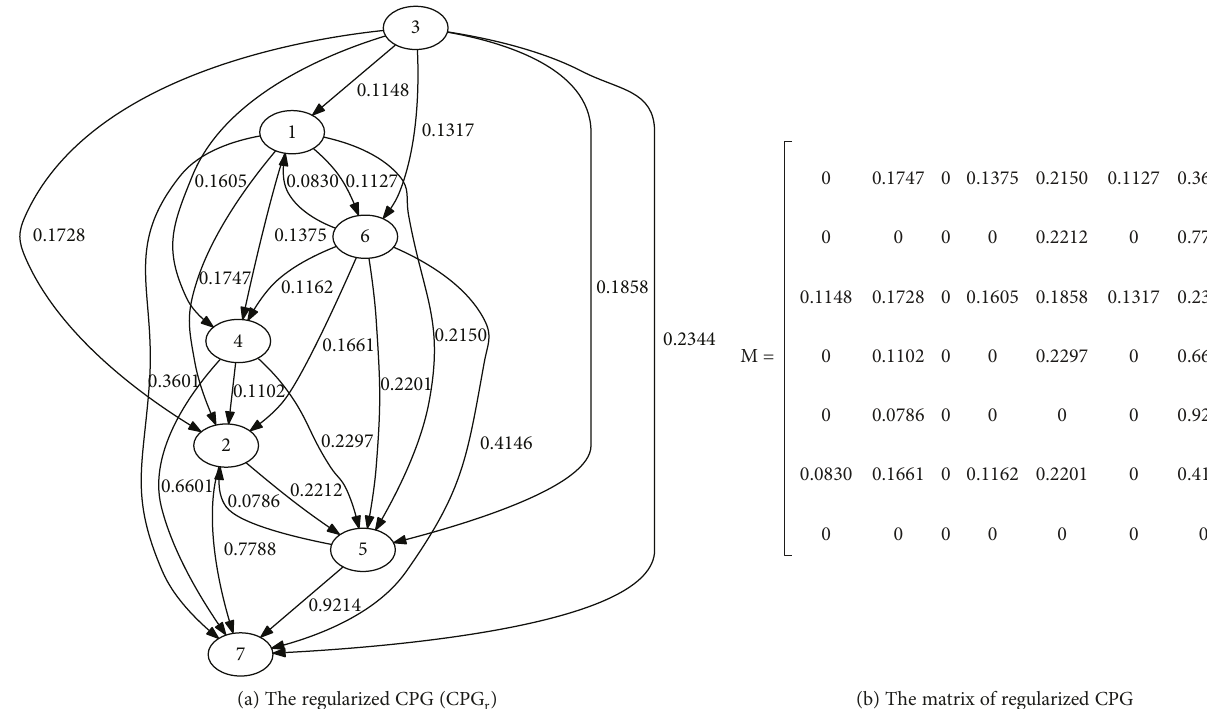
Figure 5: The regularized CPG and the corresponding matrix for the example